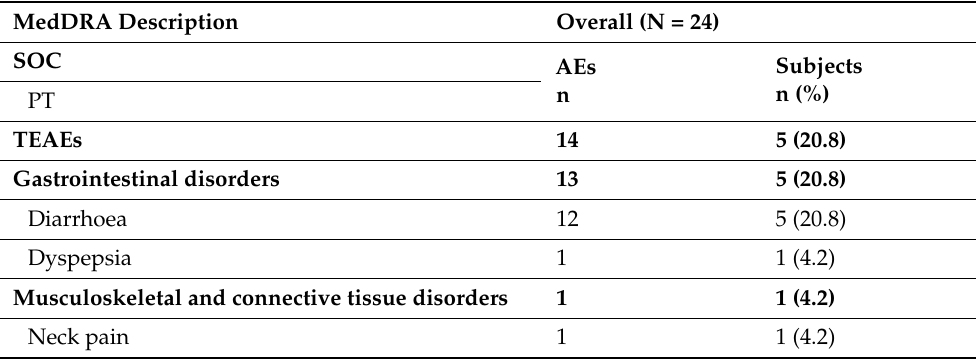
Table 6. Number of subjects reporting and number of reported treatment emergent adverse events by system organ class (SOC) and preferred term (PT) (safety